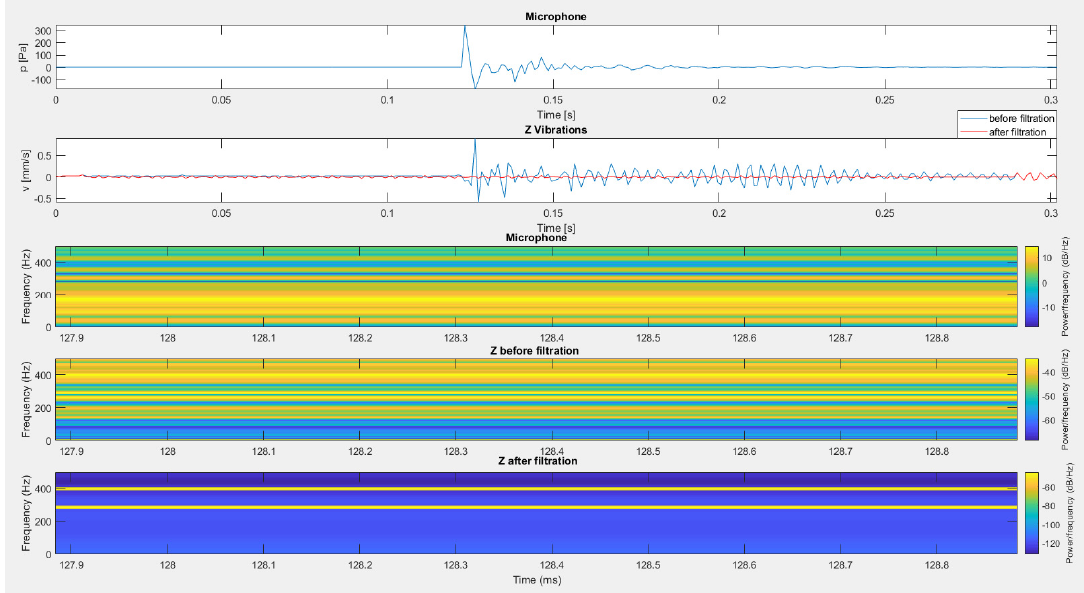
Figure 16. The result of using filtration for a vertical component from a sensor located outside the building.